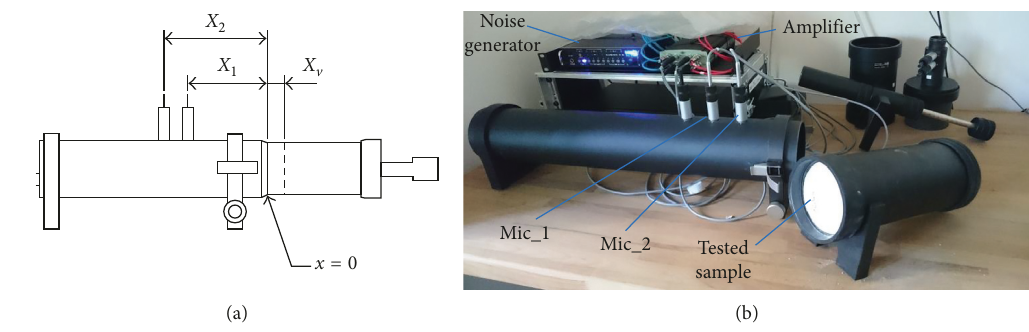
Figure 7: Experimental measurement (scheme and real